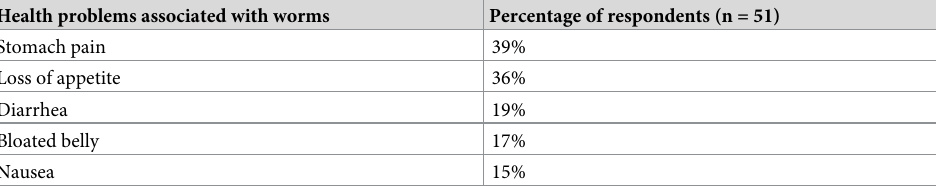
Table 3. Health problems of STH from IDI. Table 3 represents the variety of open-ended responses related to the questions, “are you aware of problems associated with worms in people?” and “can you describe what these problems are”. While 51 of 59 respondents offered an answer to this question (e.g. 86% overall), responses were open-ended and multiple answers were given. The percentages offered in the second column represent the percentage of respondents (of 51) who offered this answer. S2